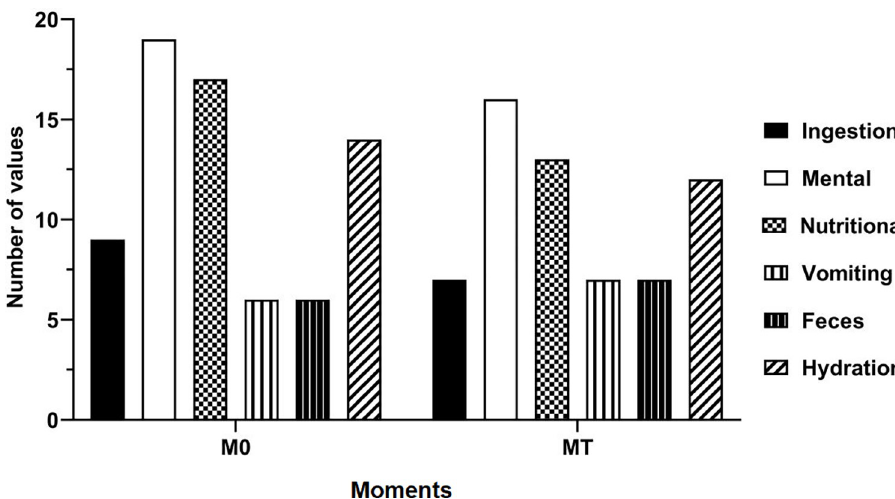
Fig 2. Clinical score plot at the first- and last-moments of clinically treated (CTG) dogs with stage IV